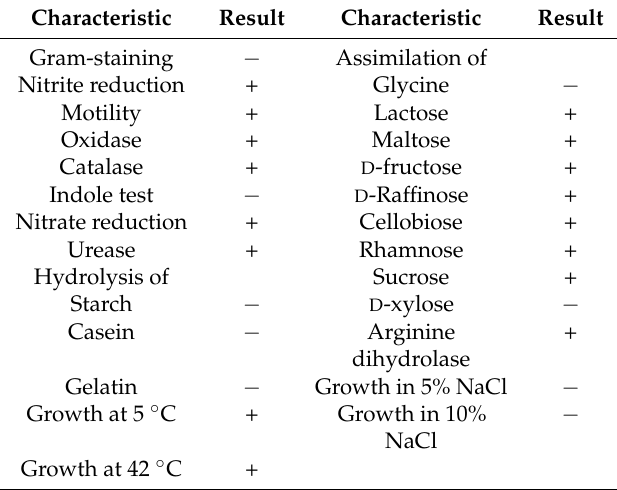
Table 1. Physiological and biochemical characteristic of the bacterial isolate Se03. Characteristic Result Characteristic Result Gram-staining − Assimilation of Nitrite